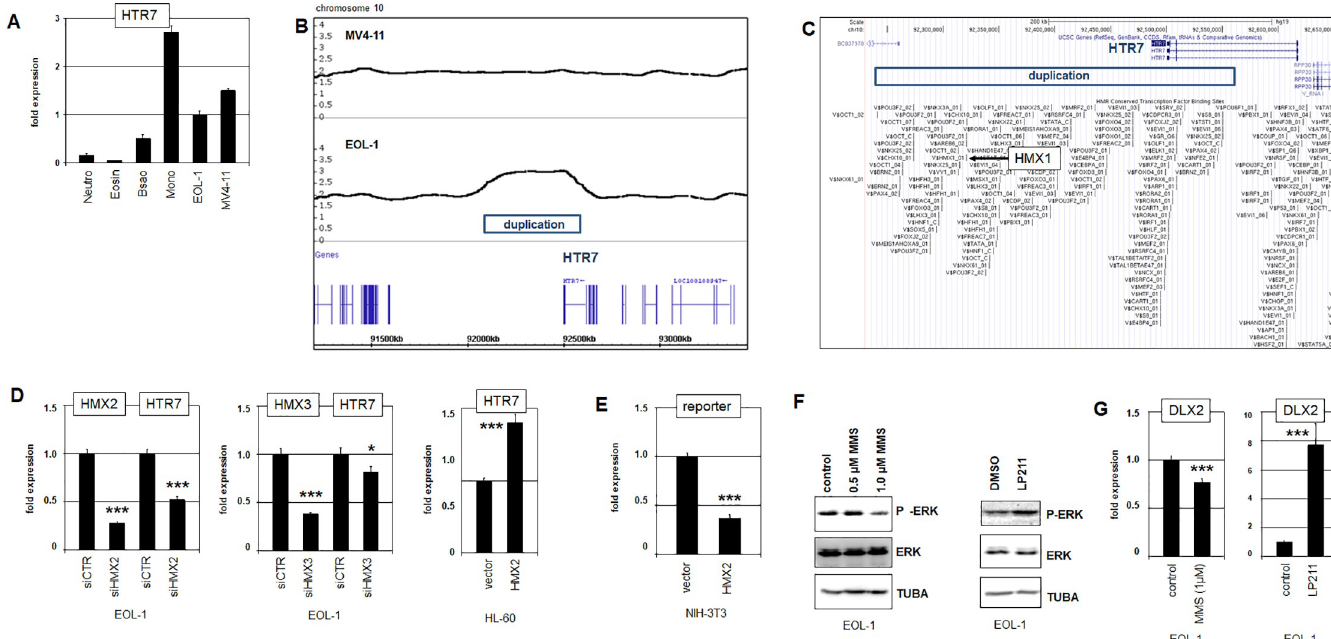
Fig 7. Regulation of HTR7 by HMX2 and HMX3. (A) Quantification of HTR7 expression in primary granulocytes (neutrophils, eosinophils, basophils), monocytes, and selected cell lines by RQ-PCR. (B) Genomic profiling data demonstrated a duplication in EOL-1 which encompassed the flanking regulatory region of HTR7. (C) A genomic map of the locus for HTR7 was taken from the UCSC genome browser, showing potential transcription factor binding sites. The indicated duplication detected in EOL-1 containes a potential HMX1-site. (D) SiRNA-mediated knockdown of HMX2 (left) and HMX3 (middle) resulted in reduced expression levels of HTR7, indicating an activating impact. Asterisks indicate calculated p-values obtained by t-Test analysis of controls (siCTR) and siRNA-targeted knockdown. Forced expression of HMX2 in HL-60 resulted in elevated transcript levels of HTR7 (right), supporting an activating impact. (E) Reporter-gene assay in NIH-3T3 cells using a fragment containing the identified HMX1-site. Forced expression of HMX2 resulted in decreased reporter-gene activity, demonstrating a direct regulatory impact. (F) Treatment of EOL-1 cells with HTR7-inhibitor MMS and HTR7-activator LP211 resulted in decreased and increased levels of ERK-phosphorylation, respectively, as shown by Western blot. (G) Treatment of EOL-1 cells with HTR7-inhibitor MMS and HTR7-activator LP211 resulted in decreased and increased levels of DLX2-transcription, respectively, as shown by RQ-PCR.